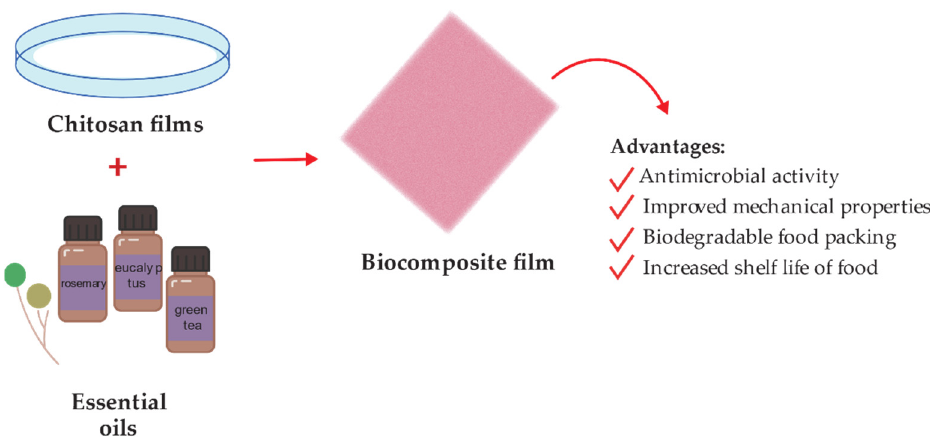
Figure 4. Schematic representation of chitosan-essential oil films preparation for food packing.